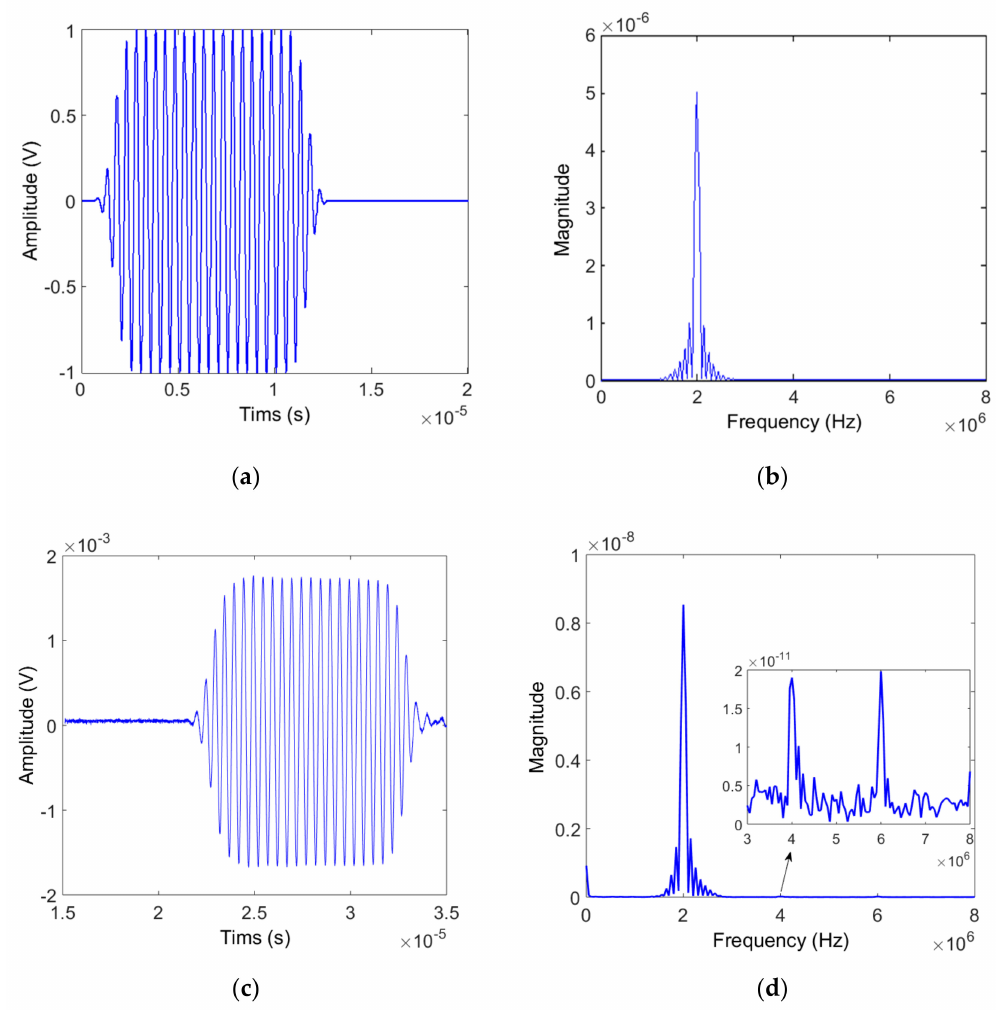
Figure 7. Input signal ( a ) Waveform and ( b ) Spectrum, and output signal ( c ) Waveform and ( d ) Spectrum.